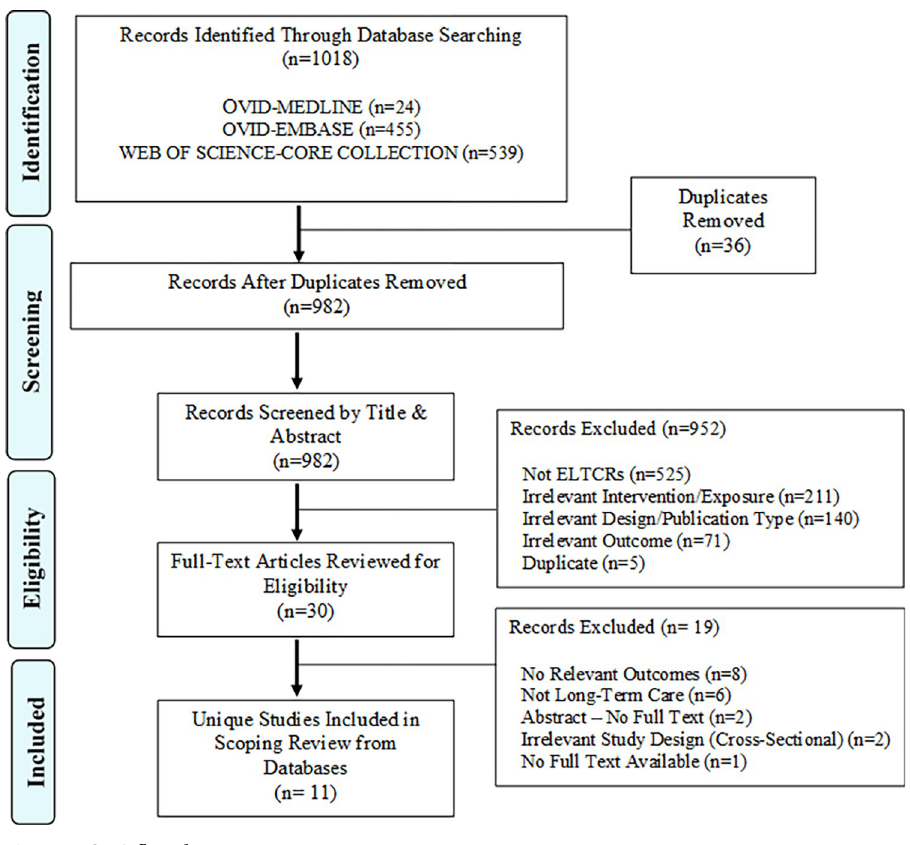
Fig 1. PRISMA flow